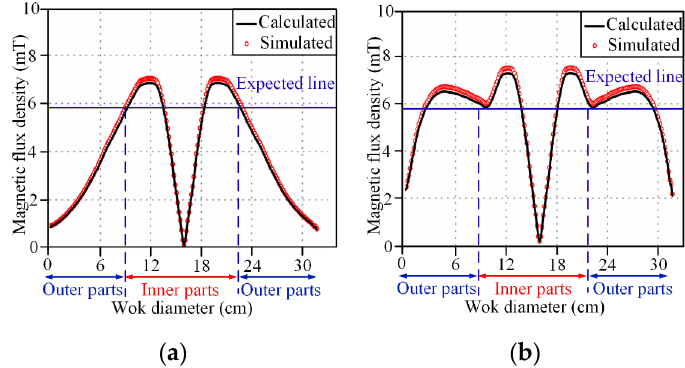
Figure 8. Magnetic flux density along wok surface. ( a ) Without frustum coil. ( b ) With frustum coil.